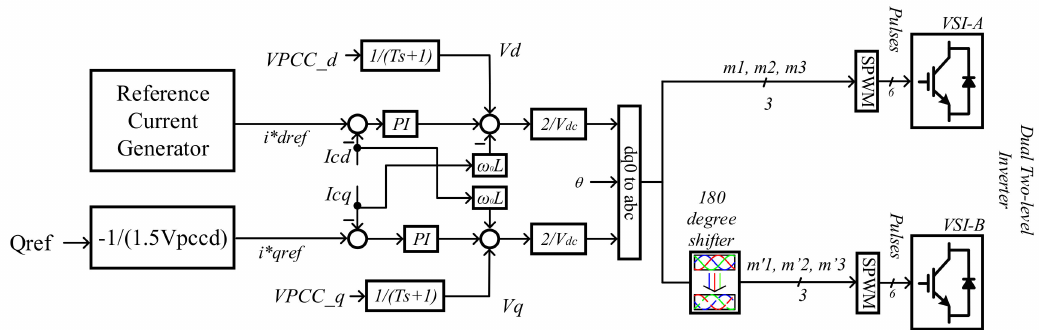
Figure 4. The current controller block